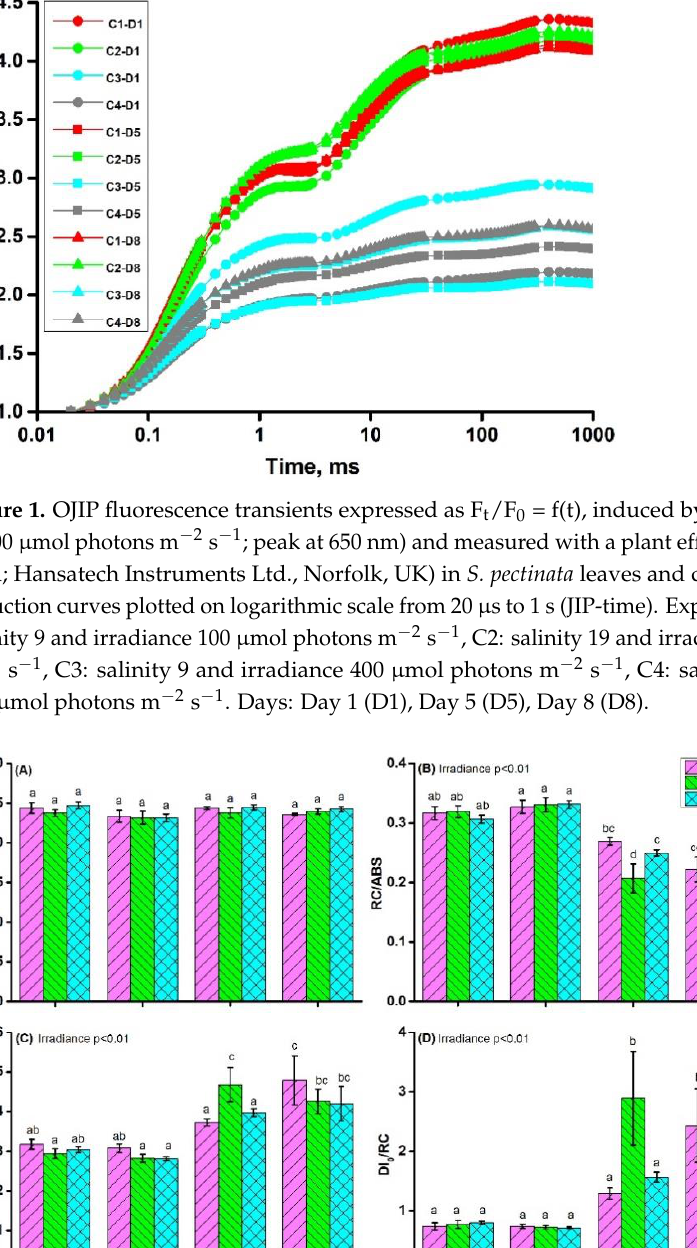
Figure 2. Effects of salinity and irradiance on ( A ) TR 0 /RC, ( B ) RC/ABS, ( C ) ABS/RC, and ( D ) DI 0 /RC. Values are means ± standard error, n = 6. Statistical differences from the post hoc test ( p < 0.01) are represented using different Latin letters. For further information see Table 1.